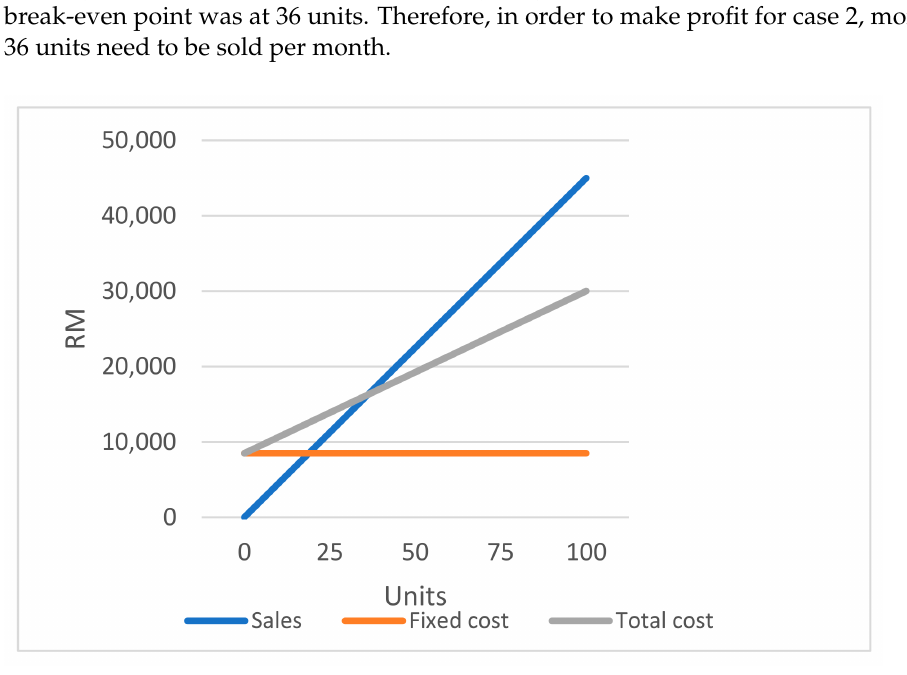
Figure 11. Break-even analysis graph for case 2.